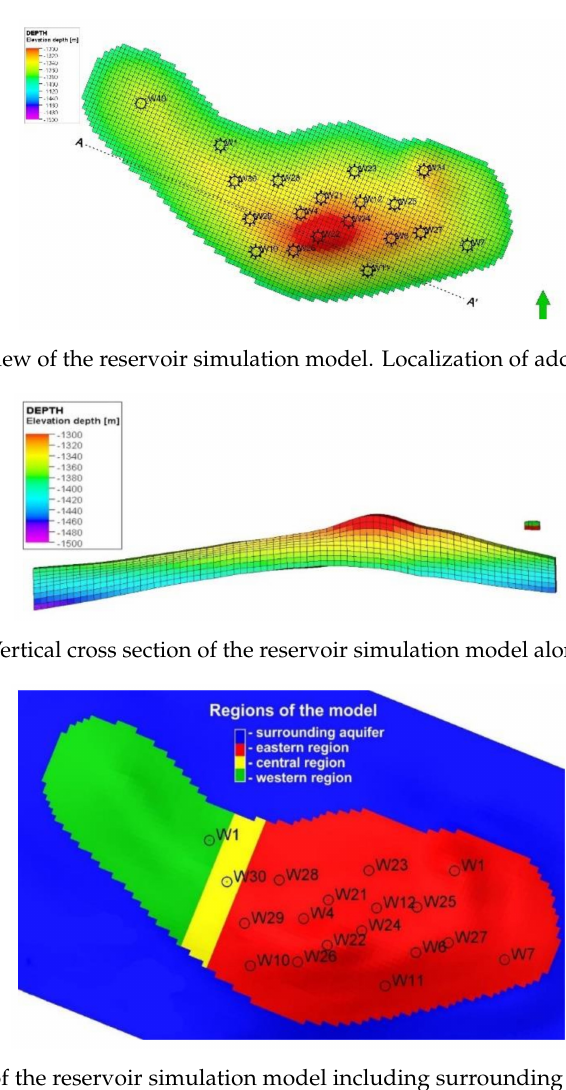
Figure 3. 3D view of the reservoir simulation model.